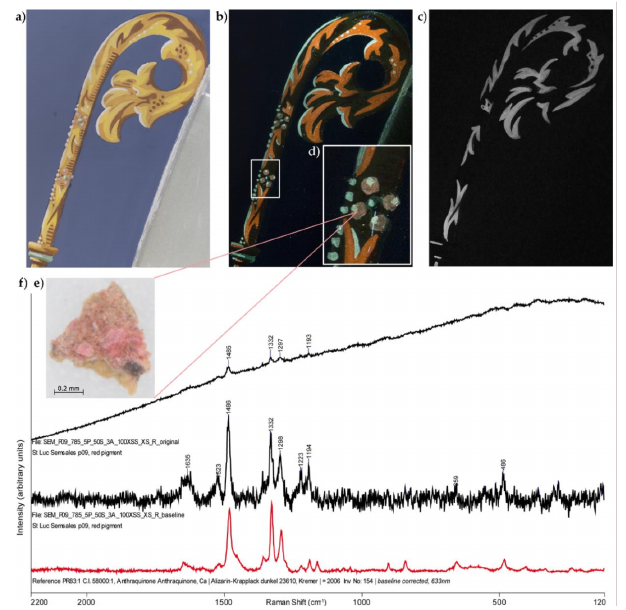
Figure 8. ( a ) Vis, ( b ) UVL and ( c ) VIL images of a detail of the crozier (image size ca. 50 cm × 75 cm) of Saint Nicolas ; ( d ) sampling area on a pink portion of the flower; ( e ) micro-sample analyzed by micro-Raman; ( f ) Raman spectrum (original and with baseline correction) compared with a reference spectrum of synthetic alizarin lake (PR83).